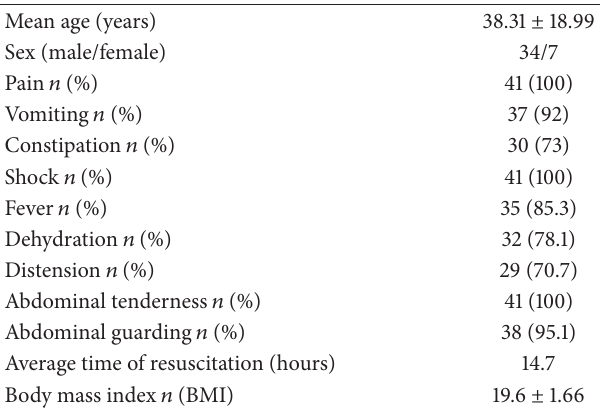
Table 1: Criteria for deciding the type of operative procedure. Table 2: Demographic and clinical profiles of